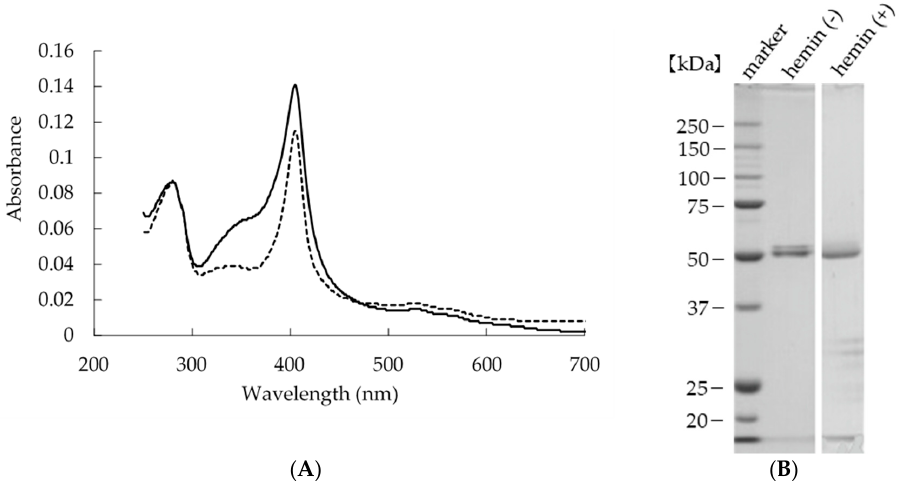
Figure 2. Analysis of purified SaDyP1, with or without hemin. ( A ) Electronic absorption spectroscopic characterization of purified SaDyP1, with or without hemin. Solid line, with hemin; dashed line, without hemin. A Soret band was observed at 406 nm. ( B ) SDS-PAGE analysis of purified SaDyP1, with or without hemin, stained with CBB. SaDyP1 was resolved by electrophoresis on a 10% polyacrylamide gel and then stained with CBB R-250.